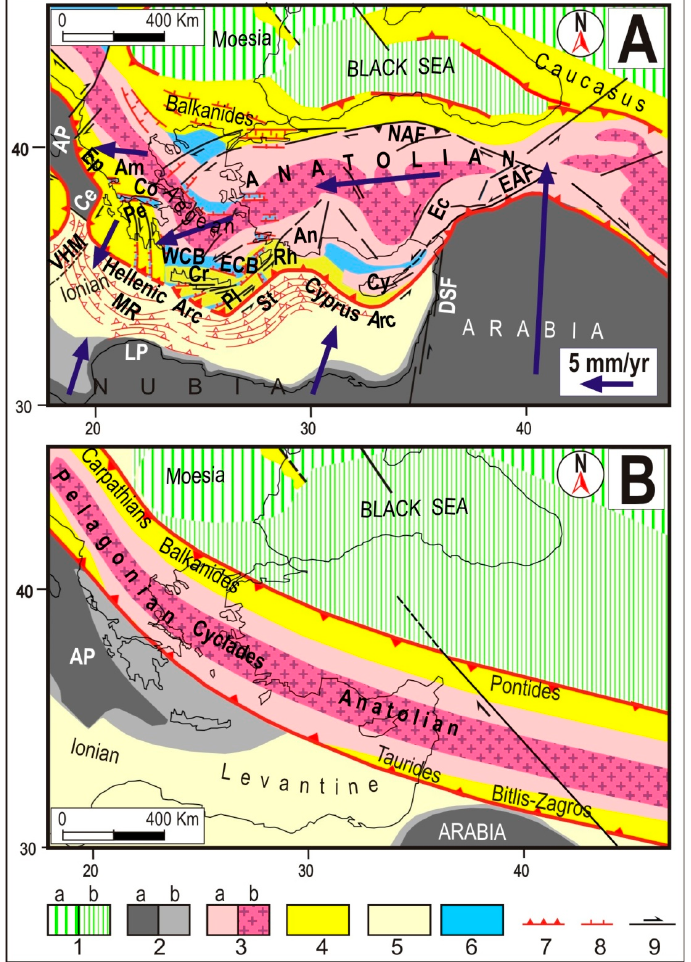
Figure 5. ( A ) Present tectonic setting. (1) Continental (a) and thinned continental (b) Eurasian domains. (2) Continental (a) and thinned continental (b) African, Adriatic and Arabian domains. (3) Inner core of the Tethyan belt, constituted by ophiolitic units (a) and crystalline massifs (b). (4) External accretionary belts with European and African affinity. (5) Ionian and Levantine oceanic domains. (6) Zones affected by crustal thinning. (7–9) Compressional, tensional and strike-slip features. The blue vectors indicate the long-term kinematic pattern [66,67]. The present shape and composition of the Tethyan belt was taken from [68–70]. Am—Ambracique trough; AP—Adriatic plate;